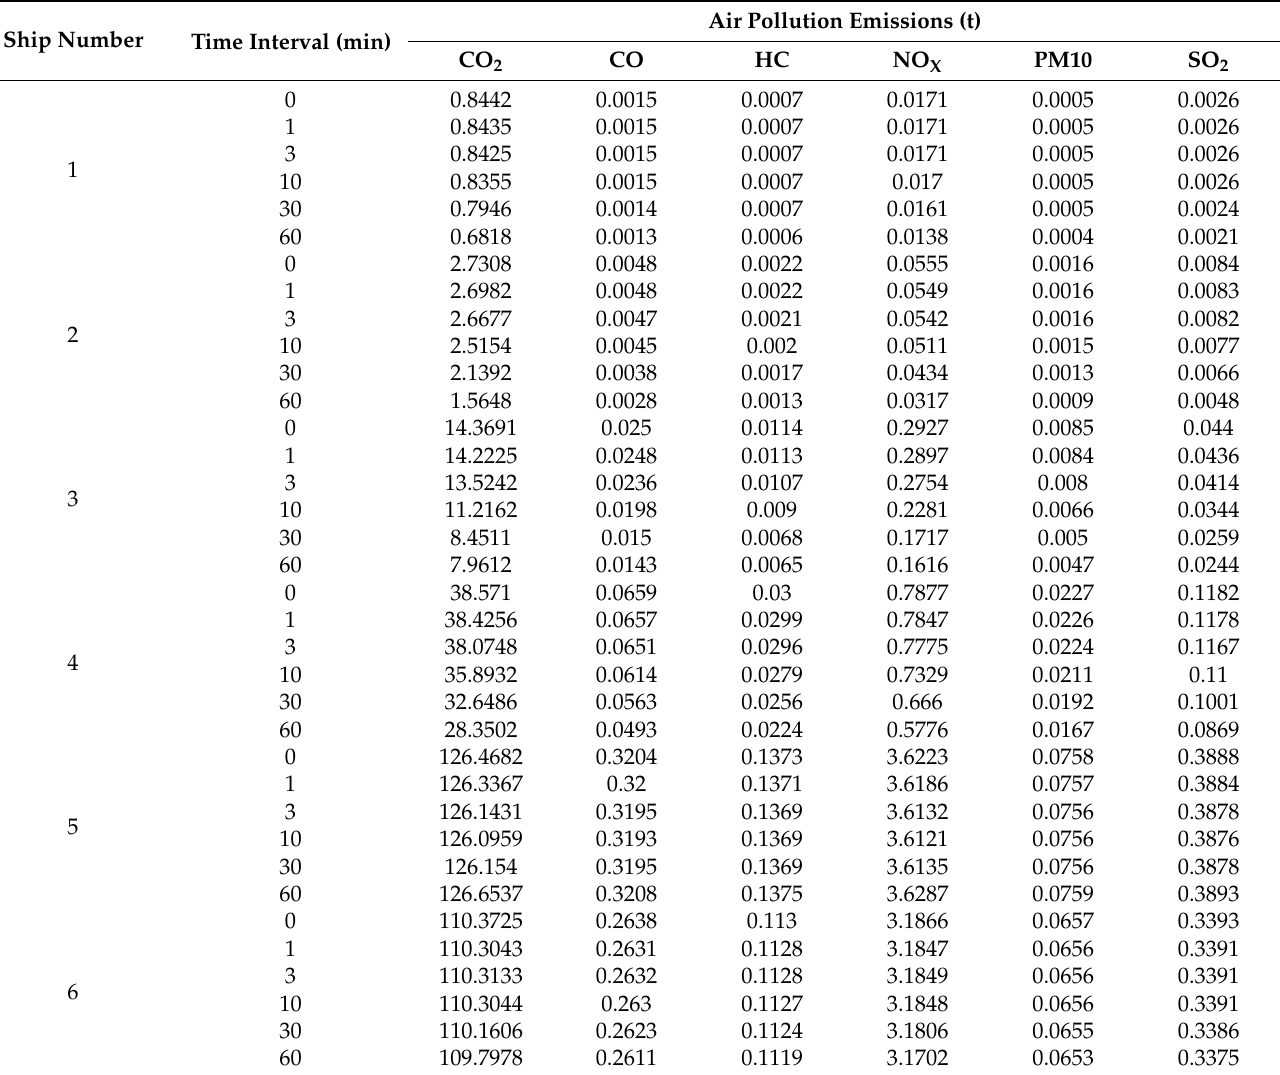
Table 2. Effect of thinning the AIS data on ship emissions inventories for one day at different time